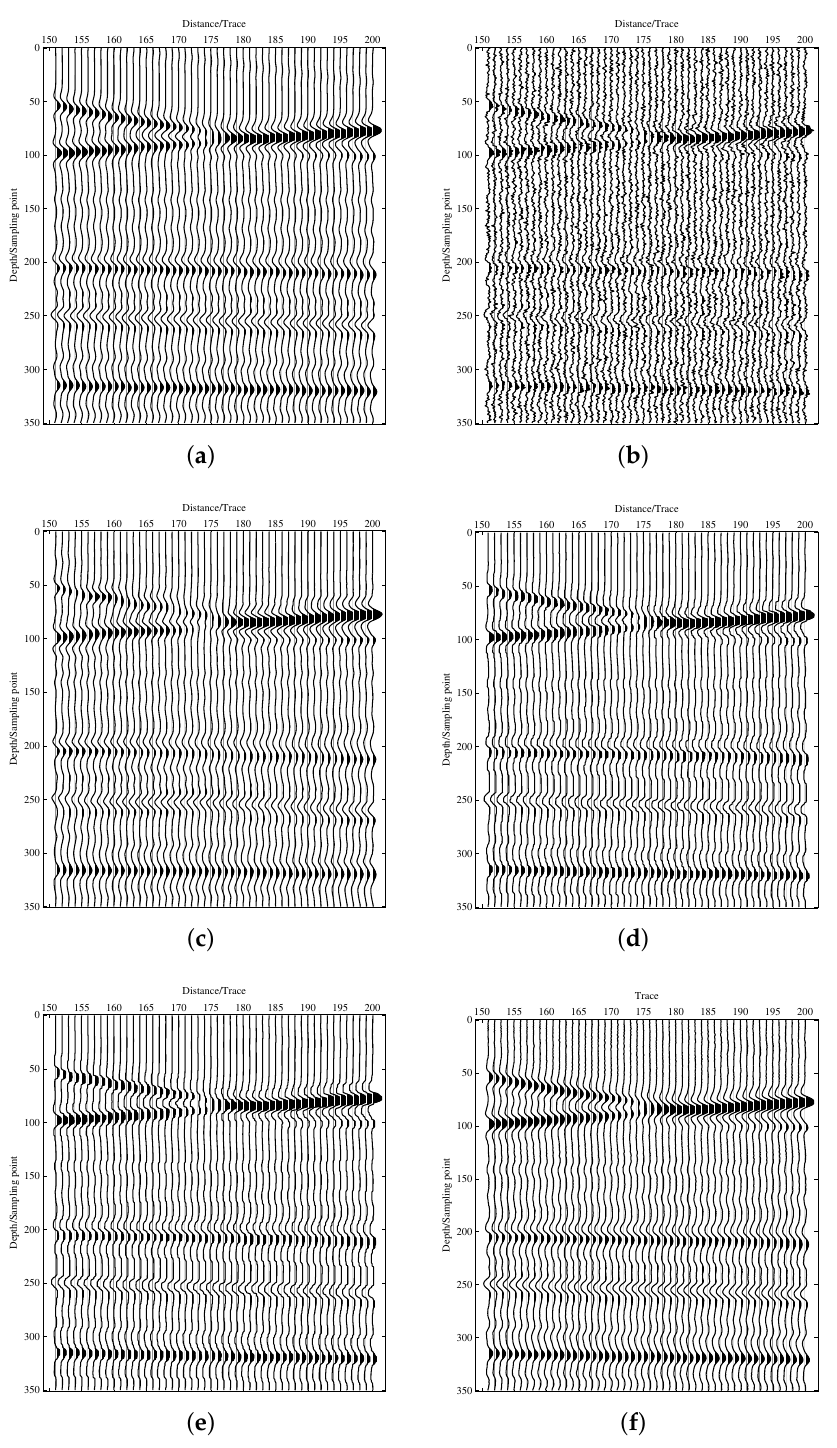
Figure 3. Waveforms of the denoising result of traces 151–200 from Figure 2 while the SNR of the input seismic data was 3 dB. ( a ) Noise-free waveforms, ( b ) noisy waveforms with the SNR of 3 dB, ( c ) wavelet denoising result, ( d ) isotropic total variation denoising (ITVD) result, ( e ) anisotropic total variation denoising (ATVD) result and ( f ) SD-SpaLR